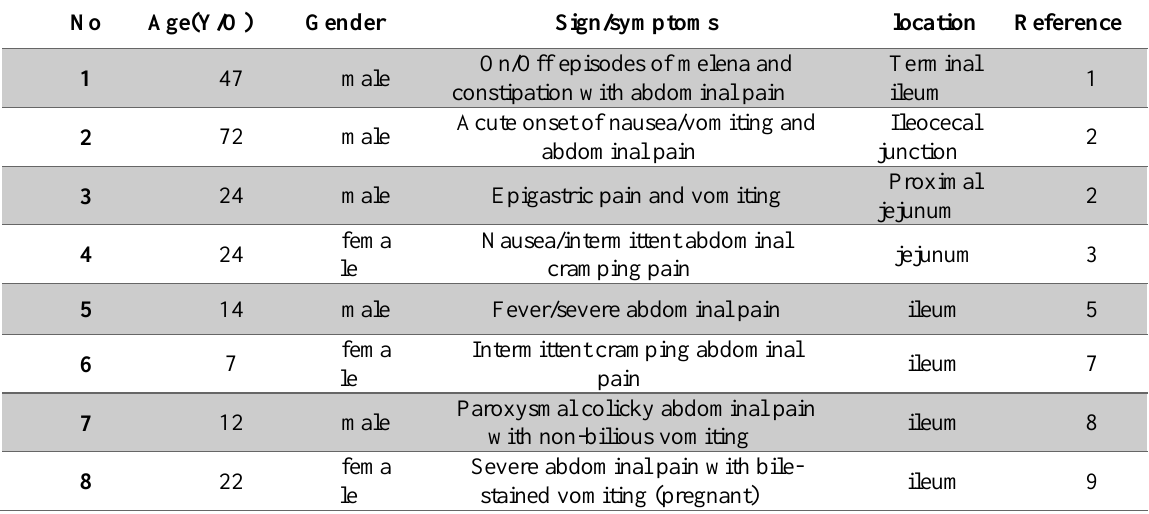
Table 1. A summary of the cases of HP leading to intestinal